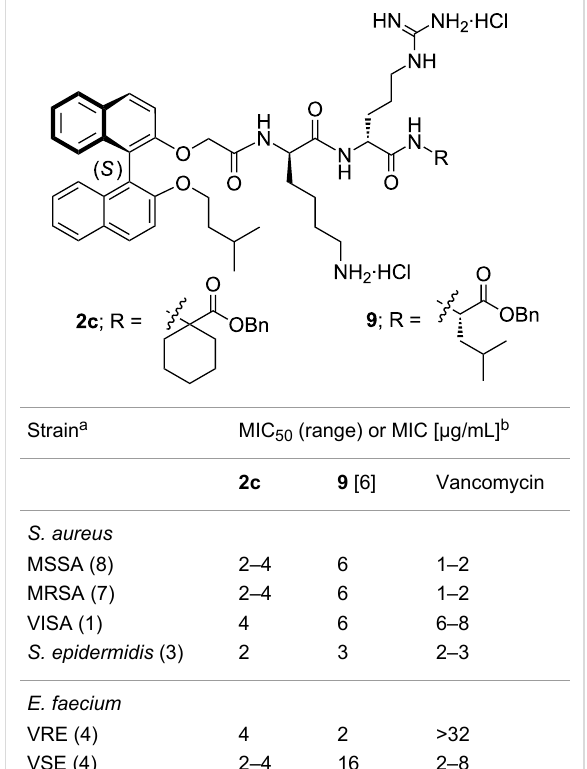
Table 2: MIC values of compounds 2c and 9 against Gram-positive